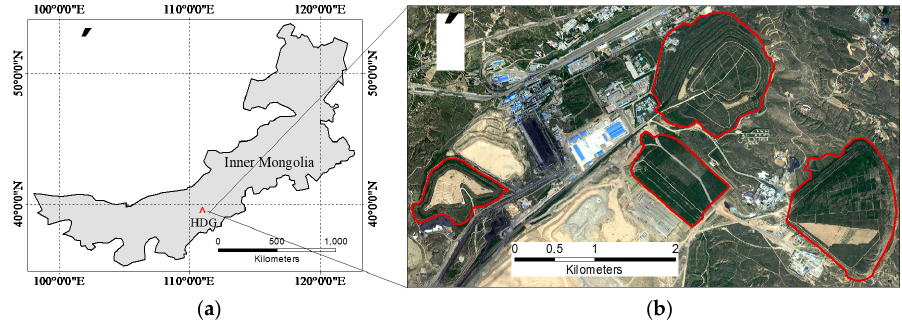
Figure 1. ( a ) Map of Inner Mongolia, China showing the location of the study area; and ( b ) Worldview-2 image of the study area acquired in 2018, showing the layout of the four mine dumps.